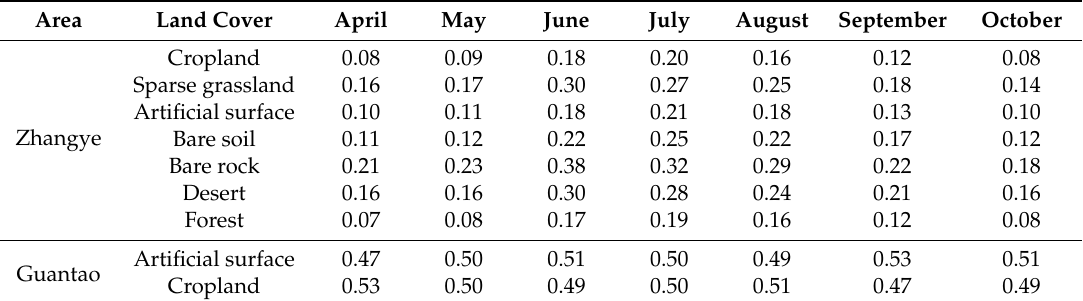
Table 5. List of Ra values used in this research (Calculated by historical data).